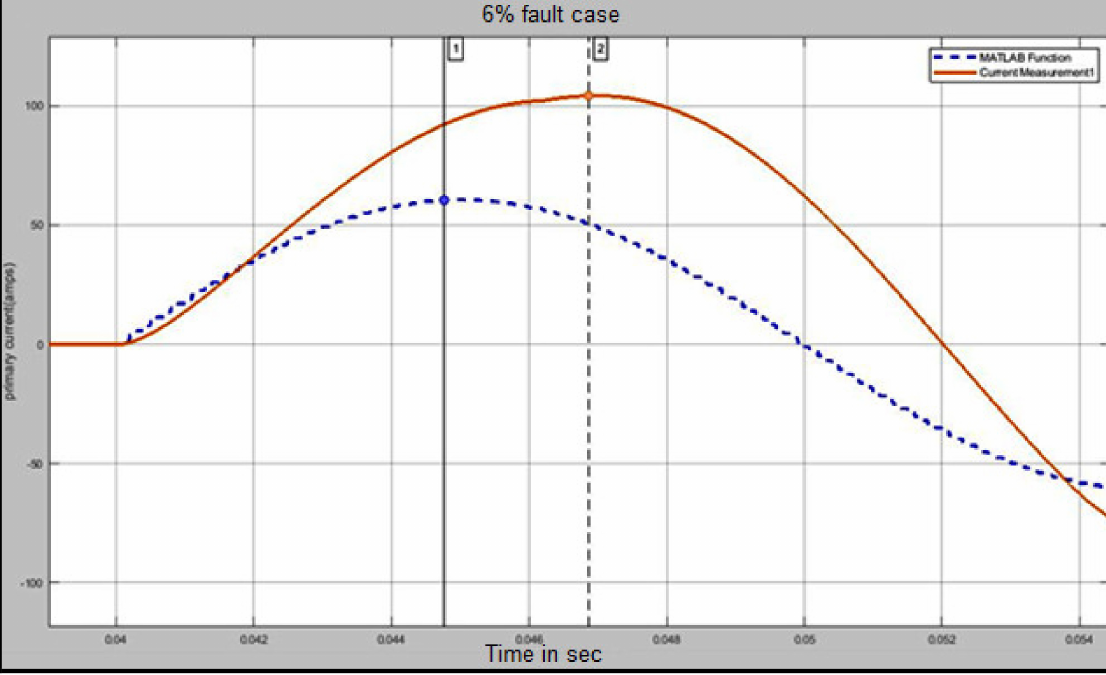
Figure 18. EKF estimation during energization with a 6% internal